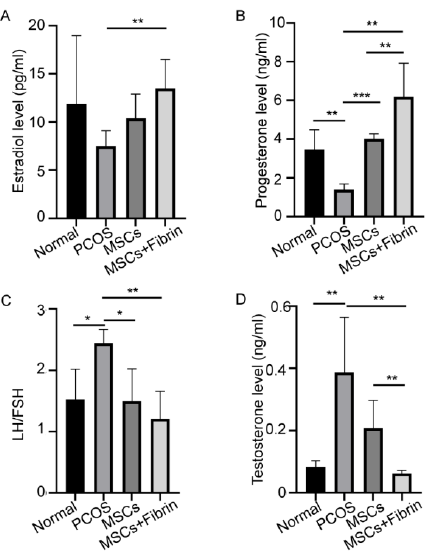
Figure 5. Treatment effect of UC-MSCs and UC-MSCs + fibrin on hormonal levels. ( A ) Levels of estradiol, ( B ) progesterone, ( C ) LH/FSH, and ( D ) testosterone (* p < 0.5, ** p < 0.01, *** p < 0.001).